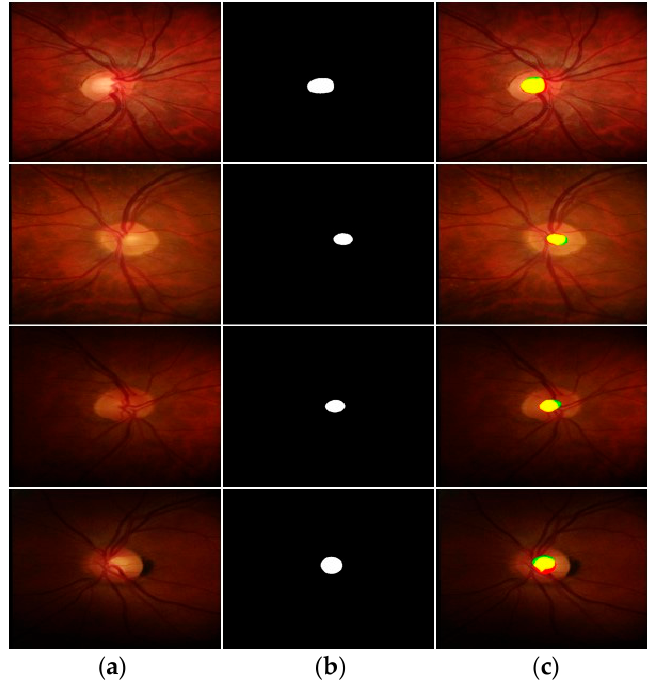
Figure 11. Good OC segmentation qualitative results on the Rim-One-r3 database, attained by applying FEDS-Net. ( a ) Input image, ( b ) corresponding groundtruth image, and ( c ) segmented output images (tp and fn pixels for OD are indicated in yellow and red, respectively. Whereas fp pixels are presented in green color) (Rows 1–3: good segmentation results; Row 4: poor segmentation result).